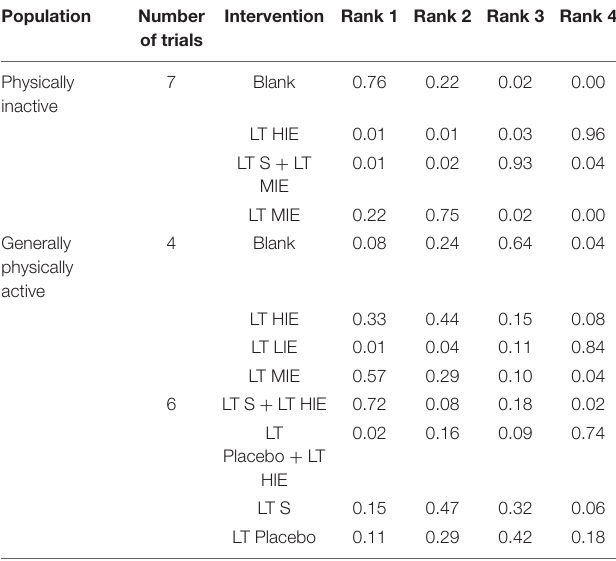
TABLE 4 | The ranking of measures and probabilities of interventions’ effect on increasing plasma superoxide dismutase (SOD) under resting-state.